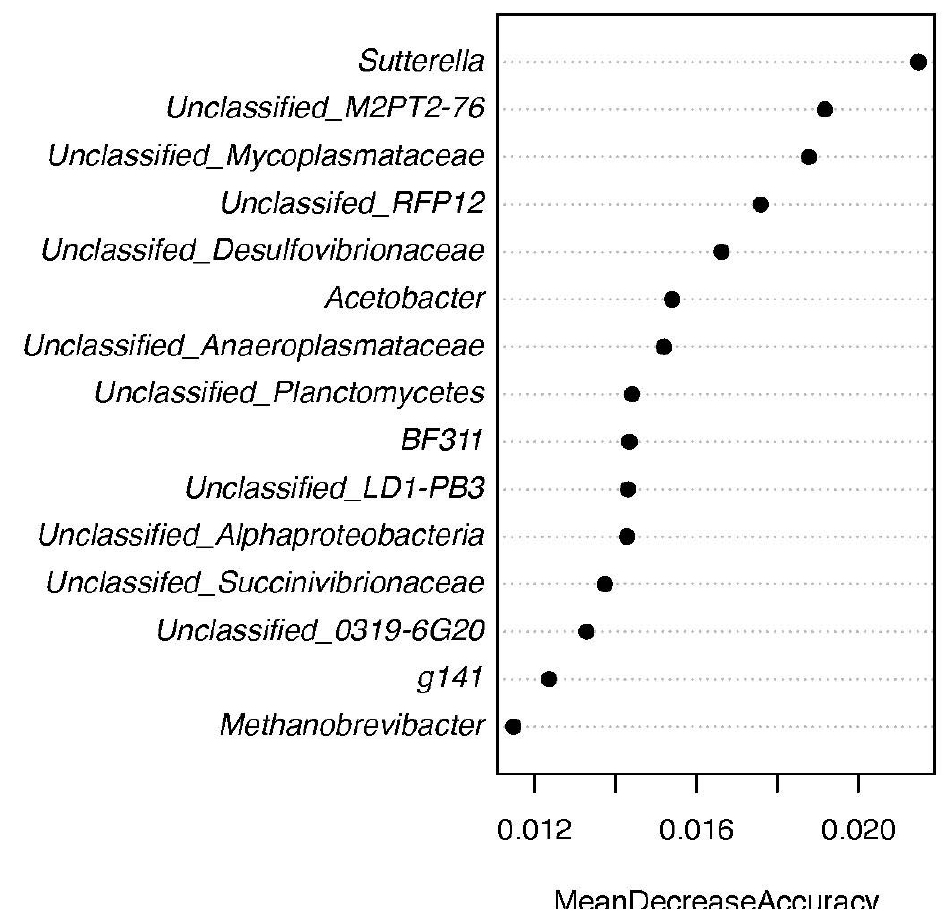
Figure 5. Random Forest analysis on remen bacterial communities of grass-fed and grain-fed Angus cattle. The y axis, from top to bottom, displays the top 15 genera ranked by their relative importance based on Mean Decrease Accuracy in the classification of